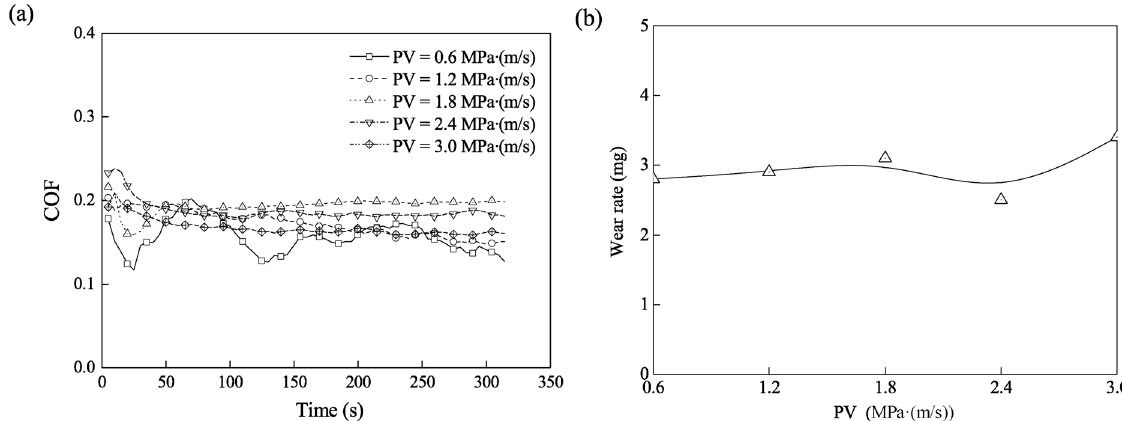
Fig. 6 (a) COFs and (b) wear rate with the S07 steel disk with DLC film under the dry-friction